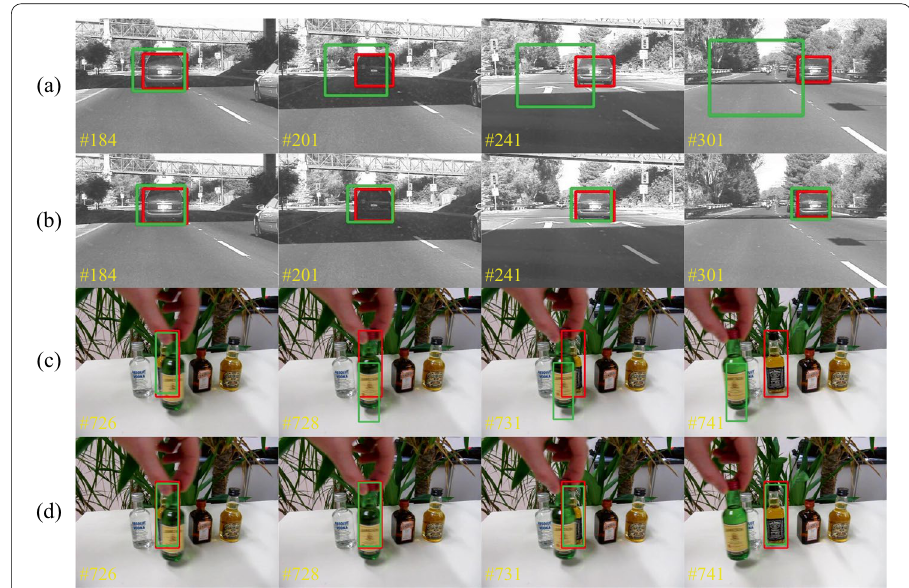
Fig. 9 Comparison of online or non-online training the